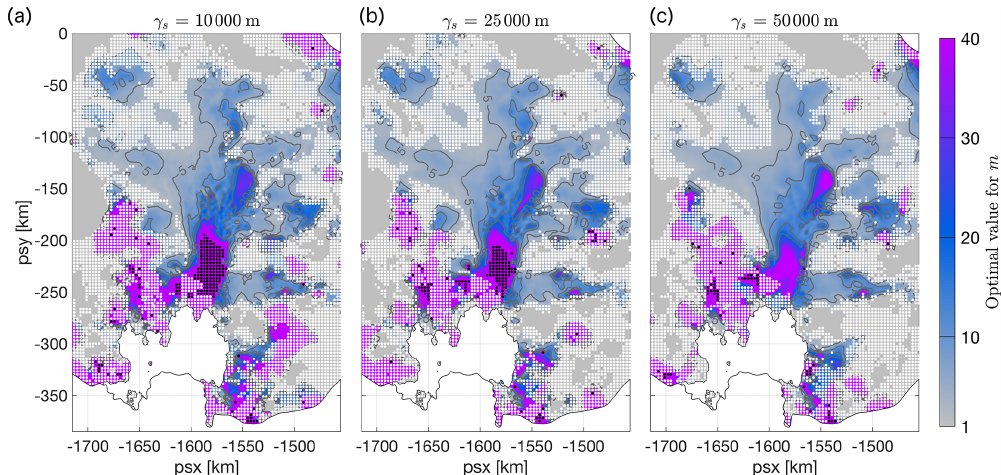
Figure D1. Optimal distribution of m , as in Fig. 6a, for different values of the regularization multiplier: (a) γ s = 10000m, (b) γ s = 25000m, and (c) γ s = 50000m. White dots indicate areas where results for the non-linear regression method were poor, with a R 2 value smaller than 0.9. Black dots indicate areas where the value of f 1 in the fit is less than 100, indicating that agreement between simulated and observed changes in surface velocity cannot be achieve for finite values of m . The value γ s = 25000m was used throughout the main part of this